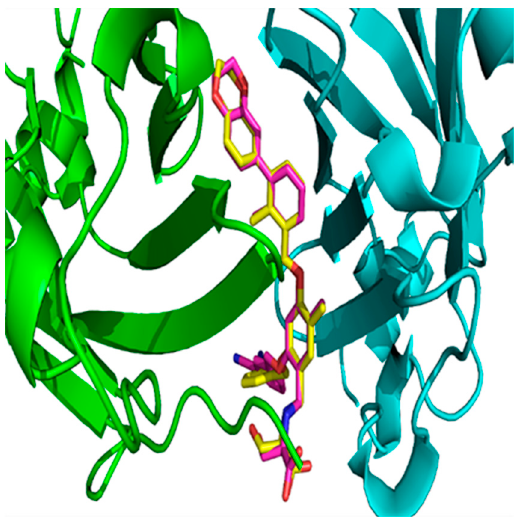
Figure 5. The superposition of the glide-docked generated pose and its native conformation in 5NIU for ligand BMS-1001 ( 1 , 5NIU) . The native confirmation is in yellow color, and the docked pose is in magenta color. Chain D is colored with a green secondary structure, whereas Chain C is in cyan color. Int. J. Mol. Sci. 2019 , 20 , x FOR PEER REVIEW